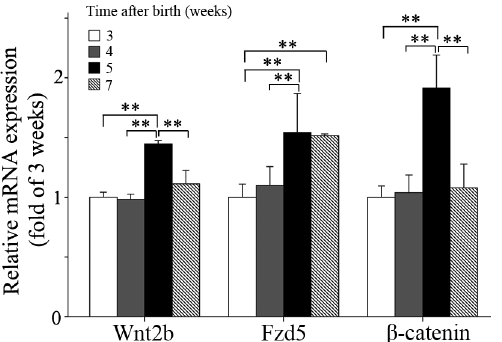
Fzd5 and b -catenin To investigate the changes of the Wnt2b signaling pathway in FDM mice, we quantified the expression of Wnt2b, Fzd5 and b - catenin mRNAs in the retinas of FDM mice. As shown in Fig. 3, the expression of Wnt2b mRNA was significantly greater in the FDM group than in the control group at 1and 4 weeks (two-way ANOVA), and significant differences were found between FDM and contralateral non-deprived eyes (two-way ANOVA) at 2 weeks. The expression of Fzd5 mRNA was significantly greater in the FDM group than in the control group at 1 and 2 weeks (two- way ANOVA). The expression of b -catenin mRNA was signifi- cantly greater in the FDM group than in the control group (two-